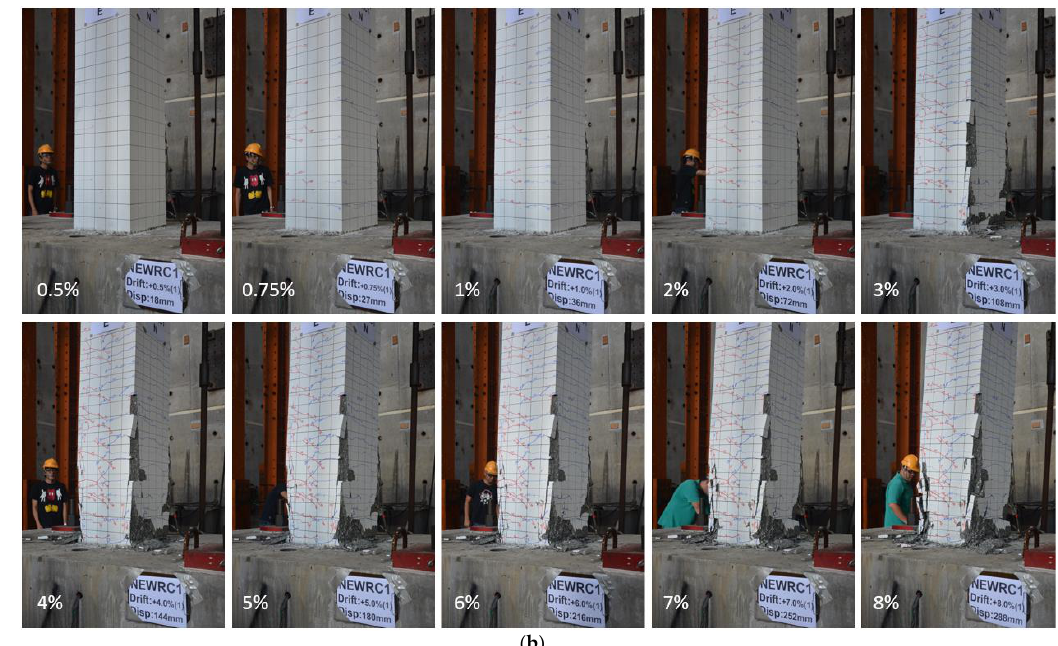
Figure 6. Crack pattern at corresponding drift ratio: ( a ) BMRC1; ( b ) NEWRC1.